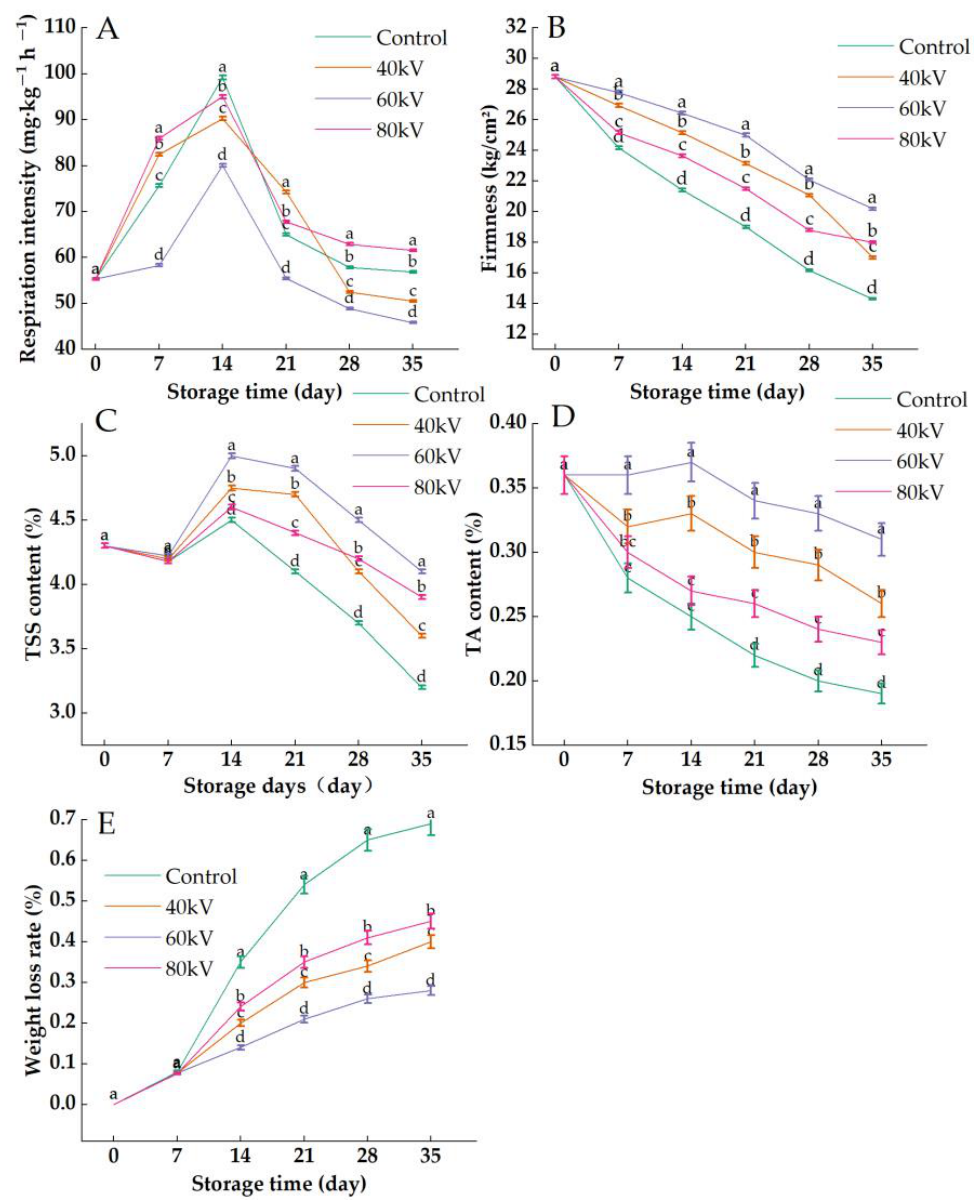
Figure 1. Effects of different intensities of ACP treatment on the respiration intensity, firmness, TSS content, TA content, and weight loss rate of tomato: ( A ) respiration intensity; ( B ) firmness; ( C ) TSS content; ( D ) TA content; ( E ) weight loss rate. Bars labeled with different small letters (a–d) indicate significant differences among different ACP treatments at the same storage time ( p ≤